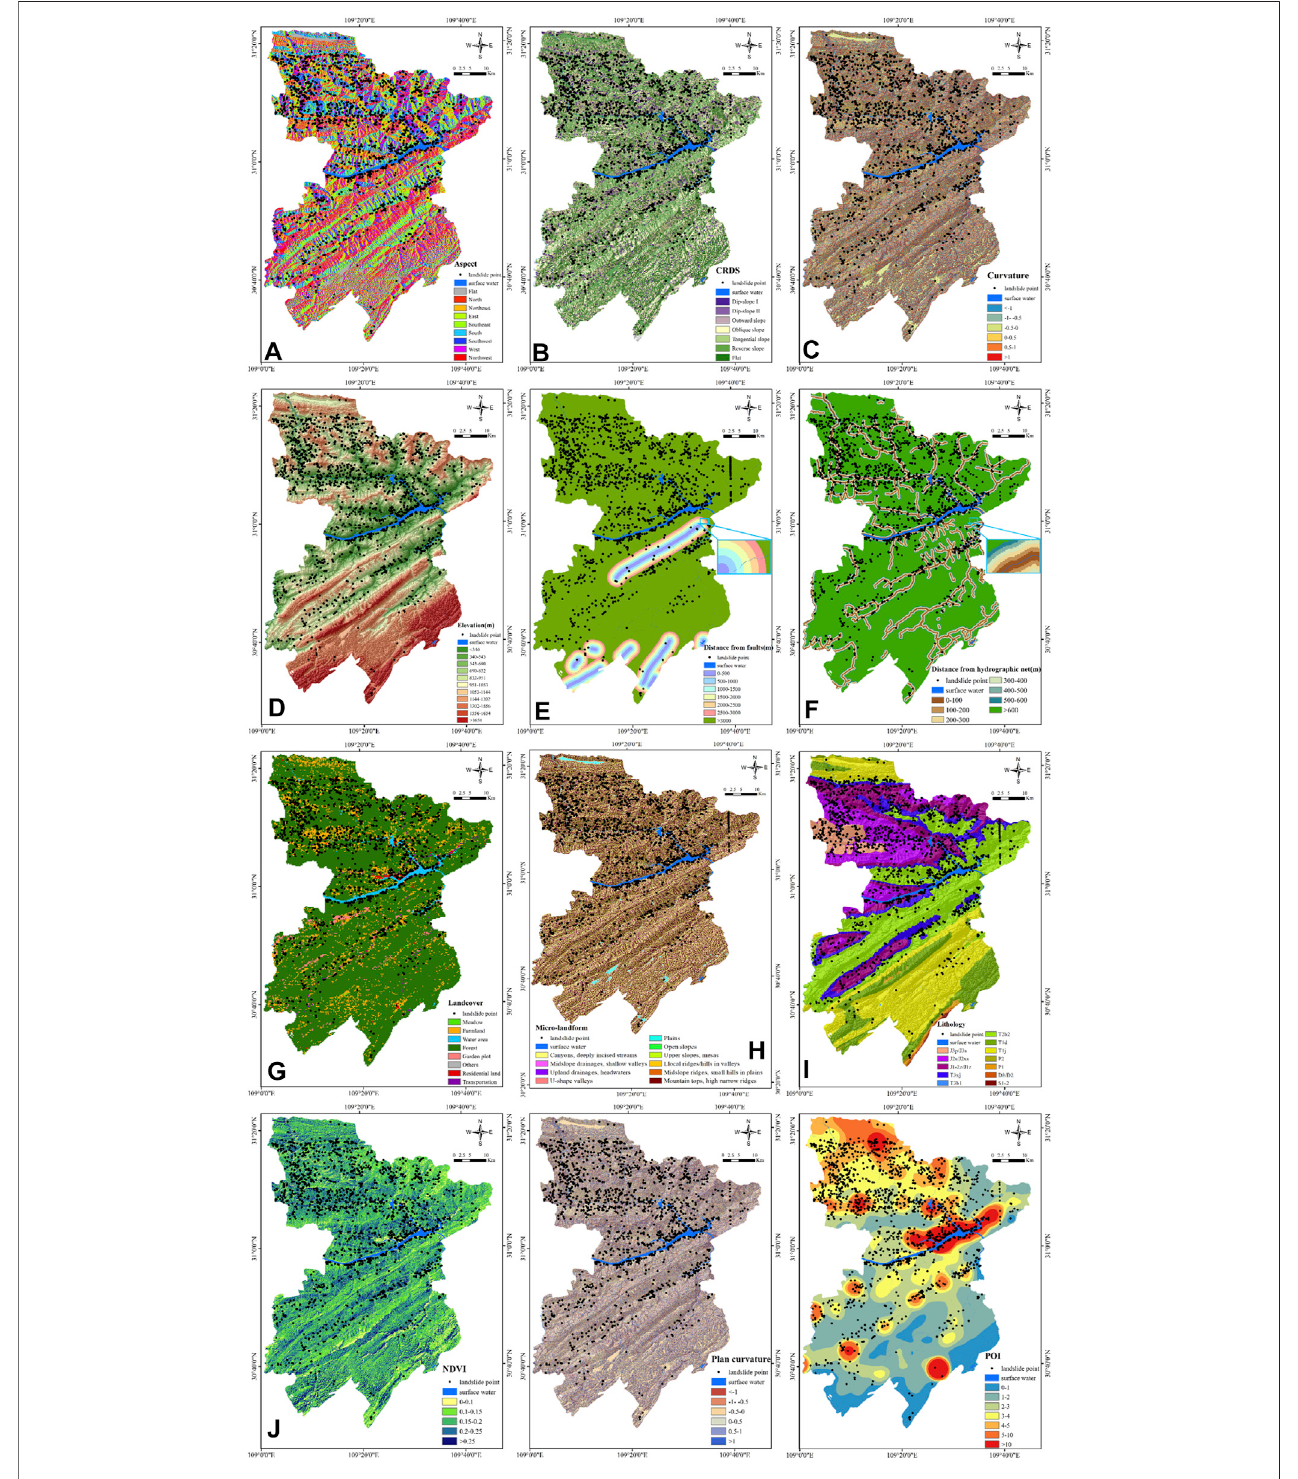
FIGURE 3 | Thematic map of landslide in fl uencing factors: (A) aspect; (B) CRDS; (C) curvature; (D) elevation; (E) distance from faults; (F) distance from hydrographic net; (G) landcover; (H) microlandform; (I) lithology; (J) NDVI; (K) plan curvature; (L) POI; (M) pro fi le curvature; (N) relief; (O) annual average rainfall; (P) slope; (Q) slope position; (R) SPI; (S) STI; (T) TRI; (U) TWI; and (V) distance from roads.